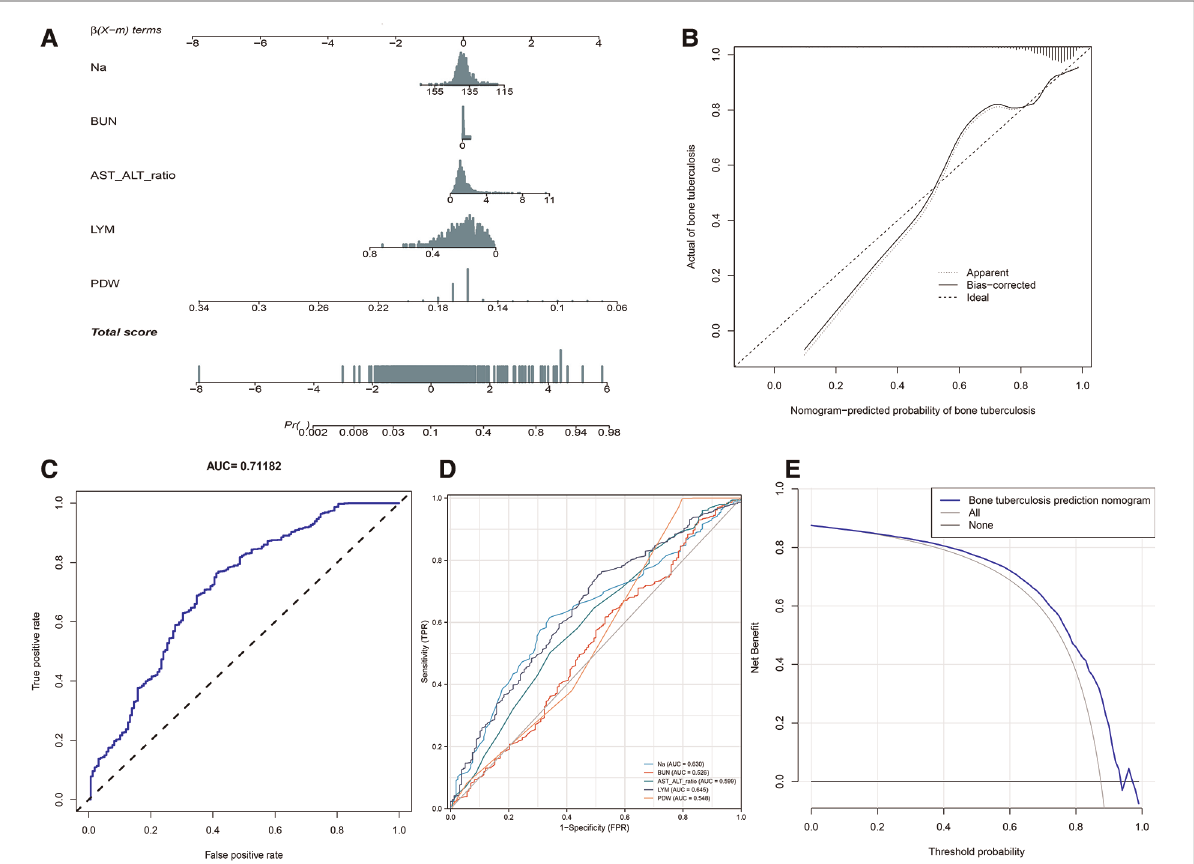
FIGURE 6 Diagnosis model. ( A ) Nomogram to predict the probability of bone and joint TB. ( B ) Calibration curves for predicting bone and joint TB. ( C ) The AUC value of the prediction model. ( D ) The AUC values of Na + , BUN, AST/ALT, LYM, and PDW. ( E ) Decision curve analysis for the prediction